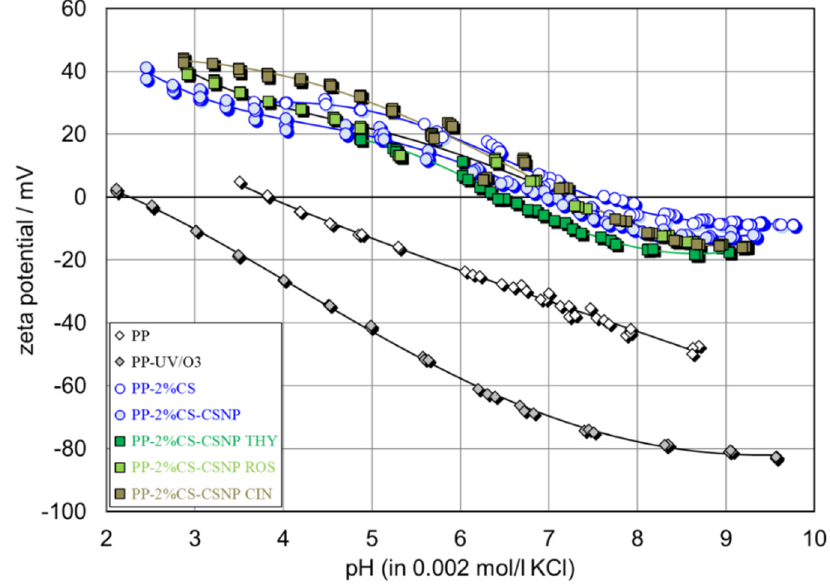
Figure 6. Zeta potential as a function of pH of PP and PP functionalized foils.